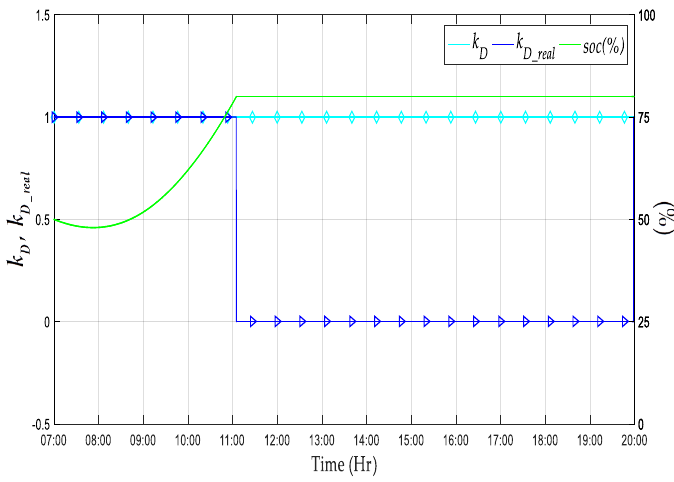
k , Figure 5. Evolution of Figure 5. Evolution of k D , k D _ real and soc without optimization by applying the α D